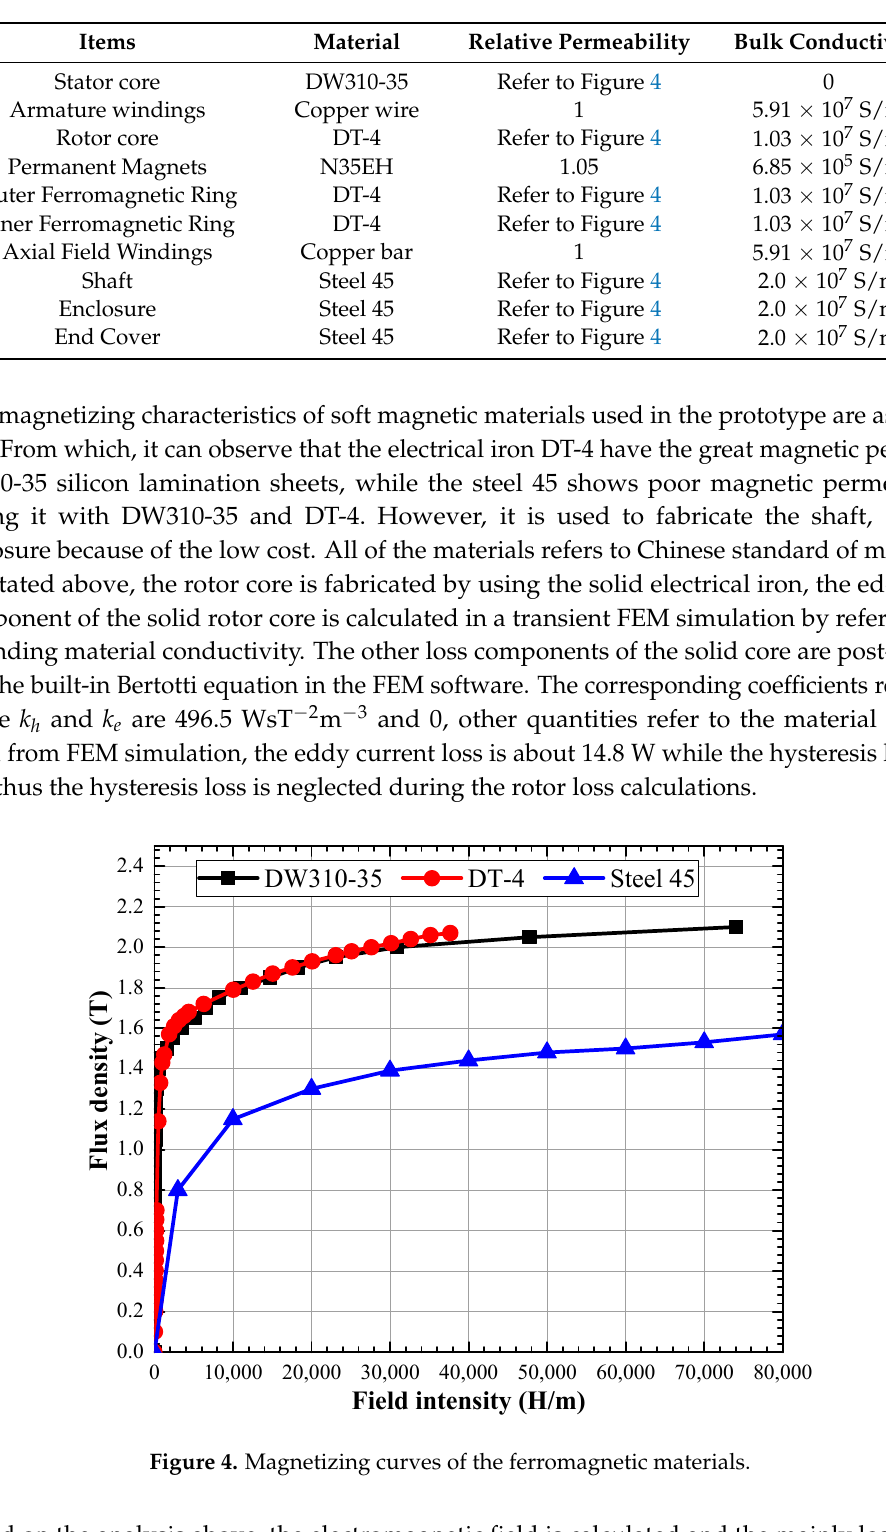
Table 2. Material properties for electromagnetic field analysis.